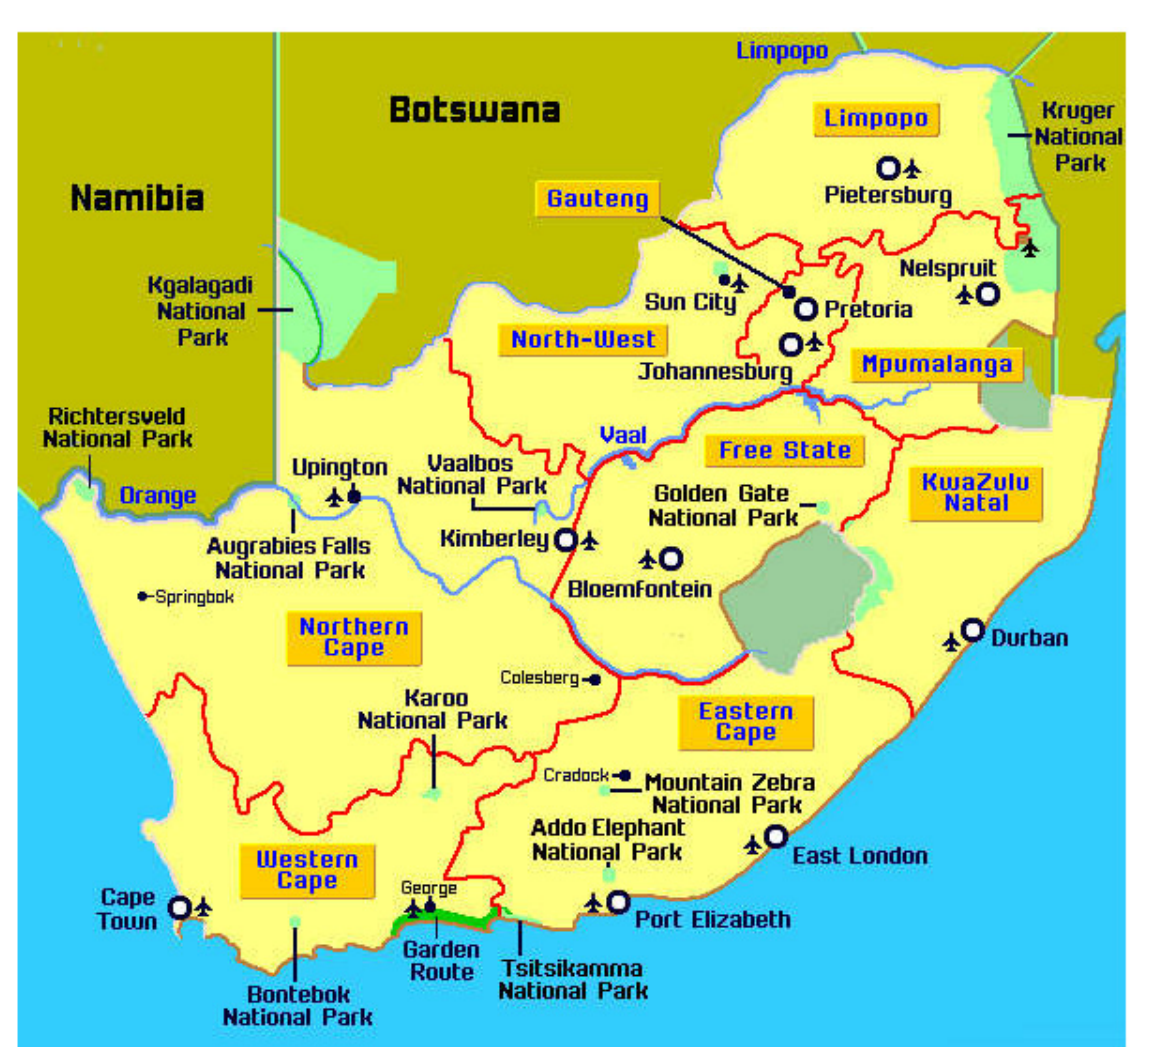
Figure 1. Map of South Africa showing the nine provinces and major cities [34].